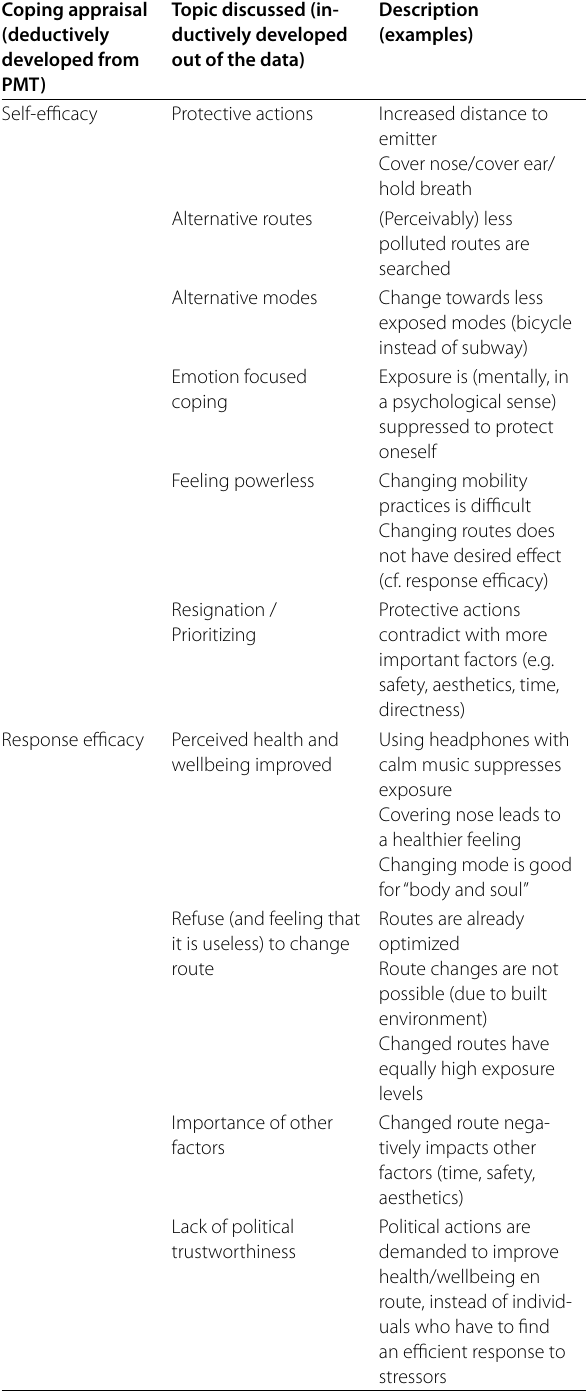
Table 1 Summary of the statements regarding coping appraisal. The particular topics as discussed by the participants during the focus groups and examples retrieved from the focus group discussion transcripts Coping appraisal (deductively developed from